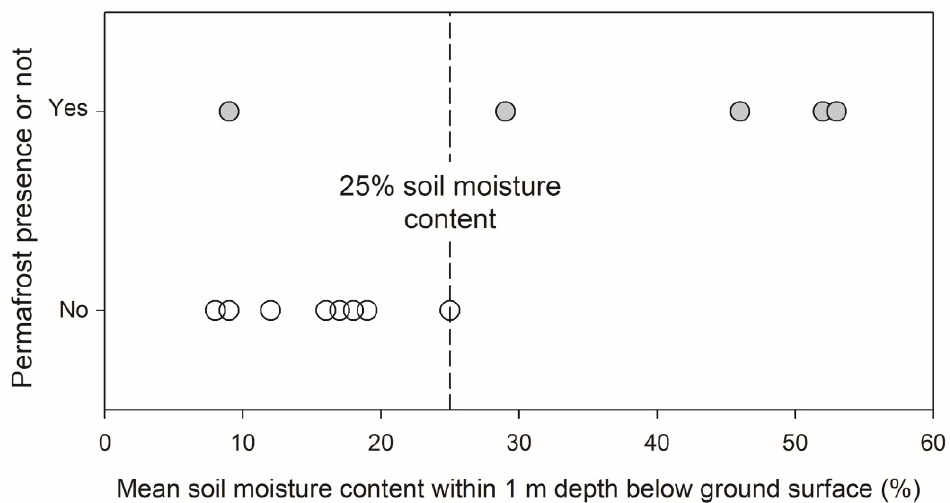
Figure 11. The existence of permafrost under different mean soil moisture content conditions. Table 3. Statistics of field survey sites for different vegetation types and permafrost existence in different frozen ground zones. ASM, AM, and AS represent alpine swamp meadow, alpine meadow, and alpine steppe, respectively.